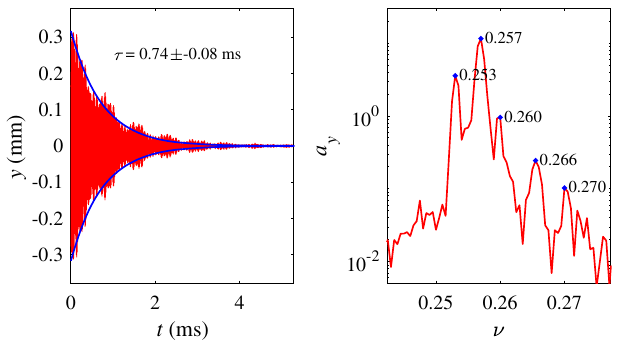
FIG. 4. Vertical turn-by-turn oscillation (left) and its spectrum ¼ 2 . 1 ; I ¼ 0 . 5 mA. (right); ξ y b